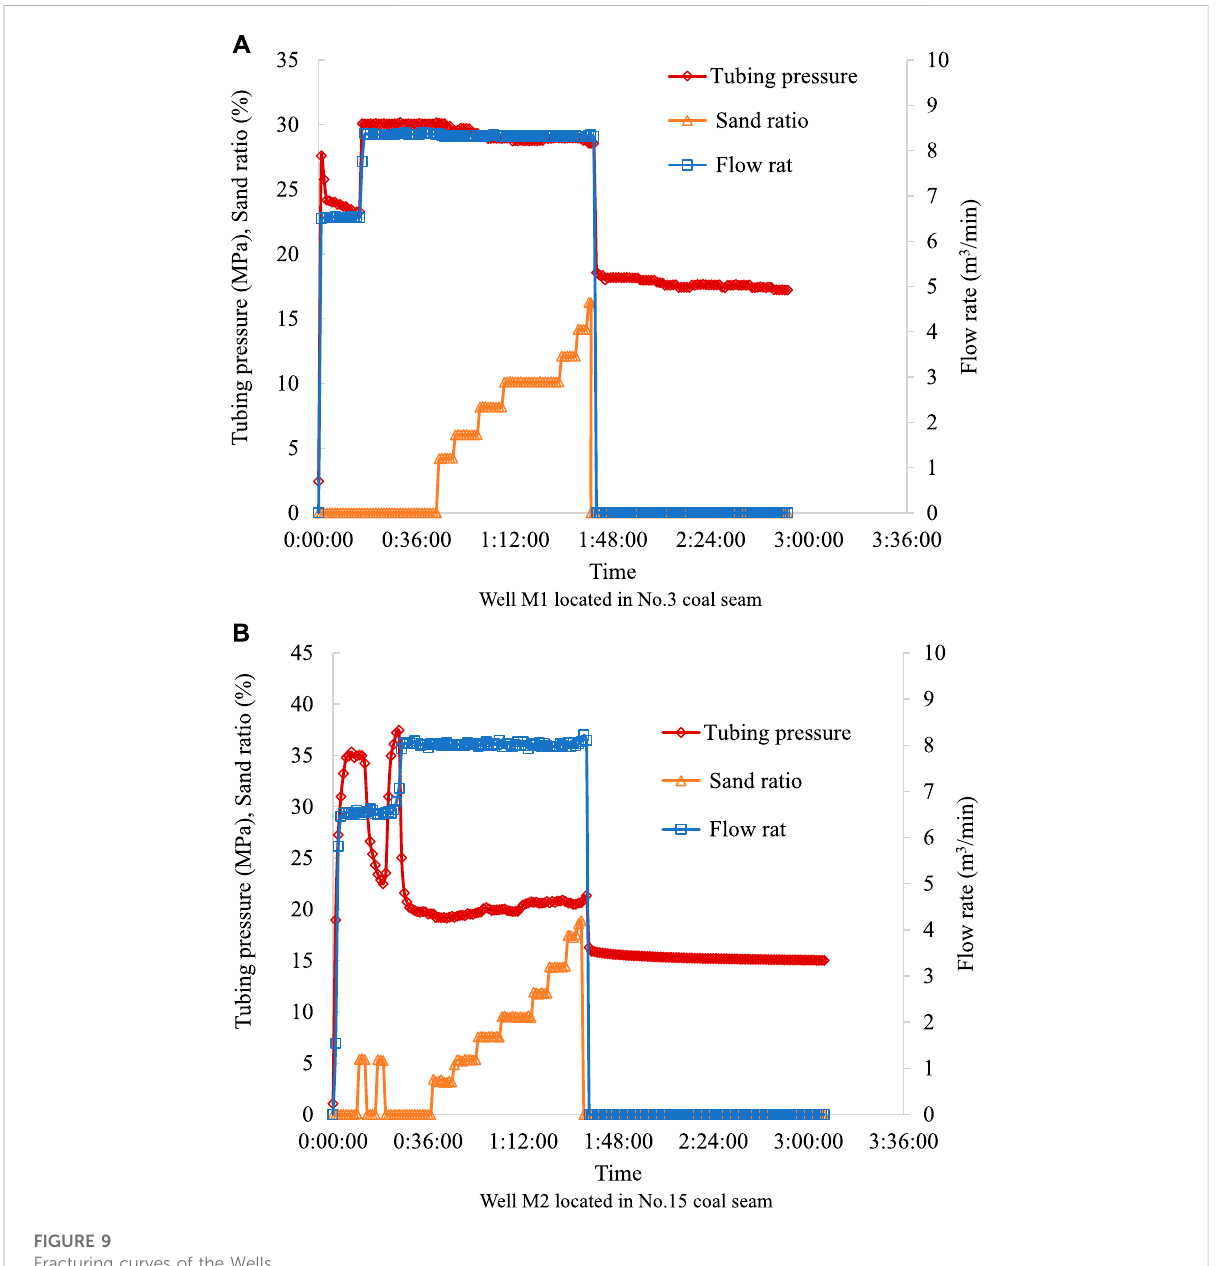
FIGURE 9 Fracturing curves of the